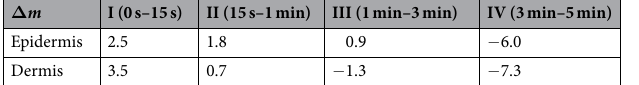
Table 2. Water mass variation (%) at epidermis and dermis during the four